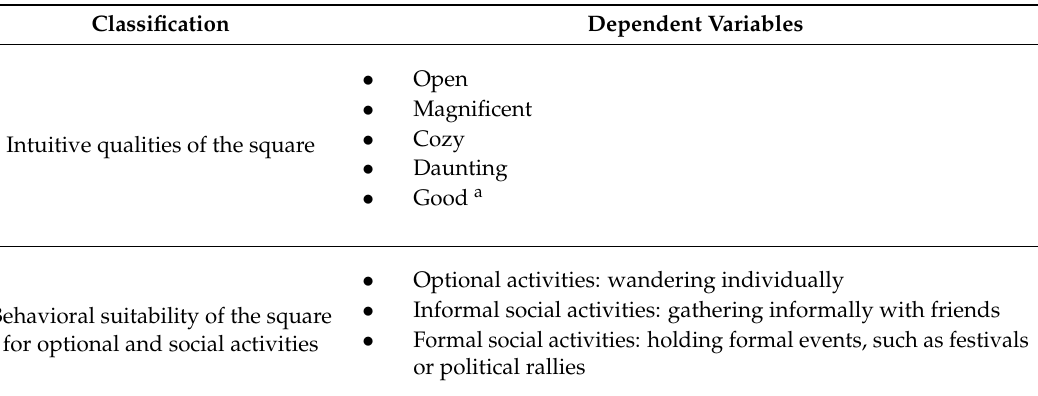
Table 2. Classification of dependent